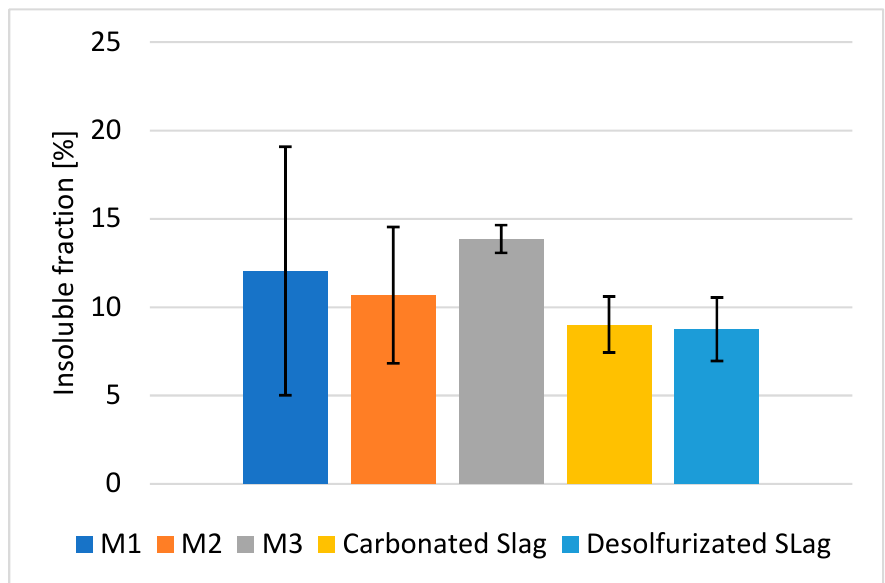
Figure 11. Insoluble fraction after HCl test of M1, M2, M3, c-BOF slag and De-S slag. The insoluble fraction that was collected after the acid attack was analyzed by